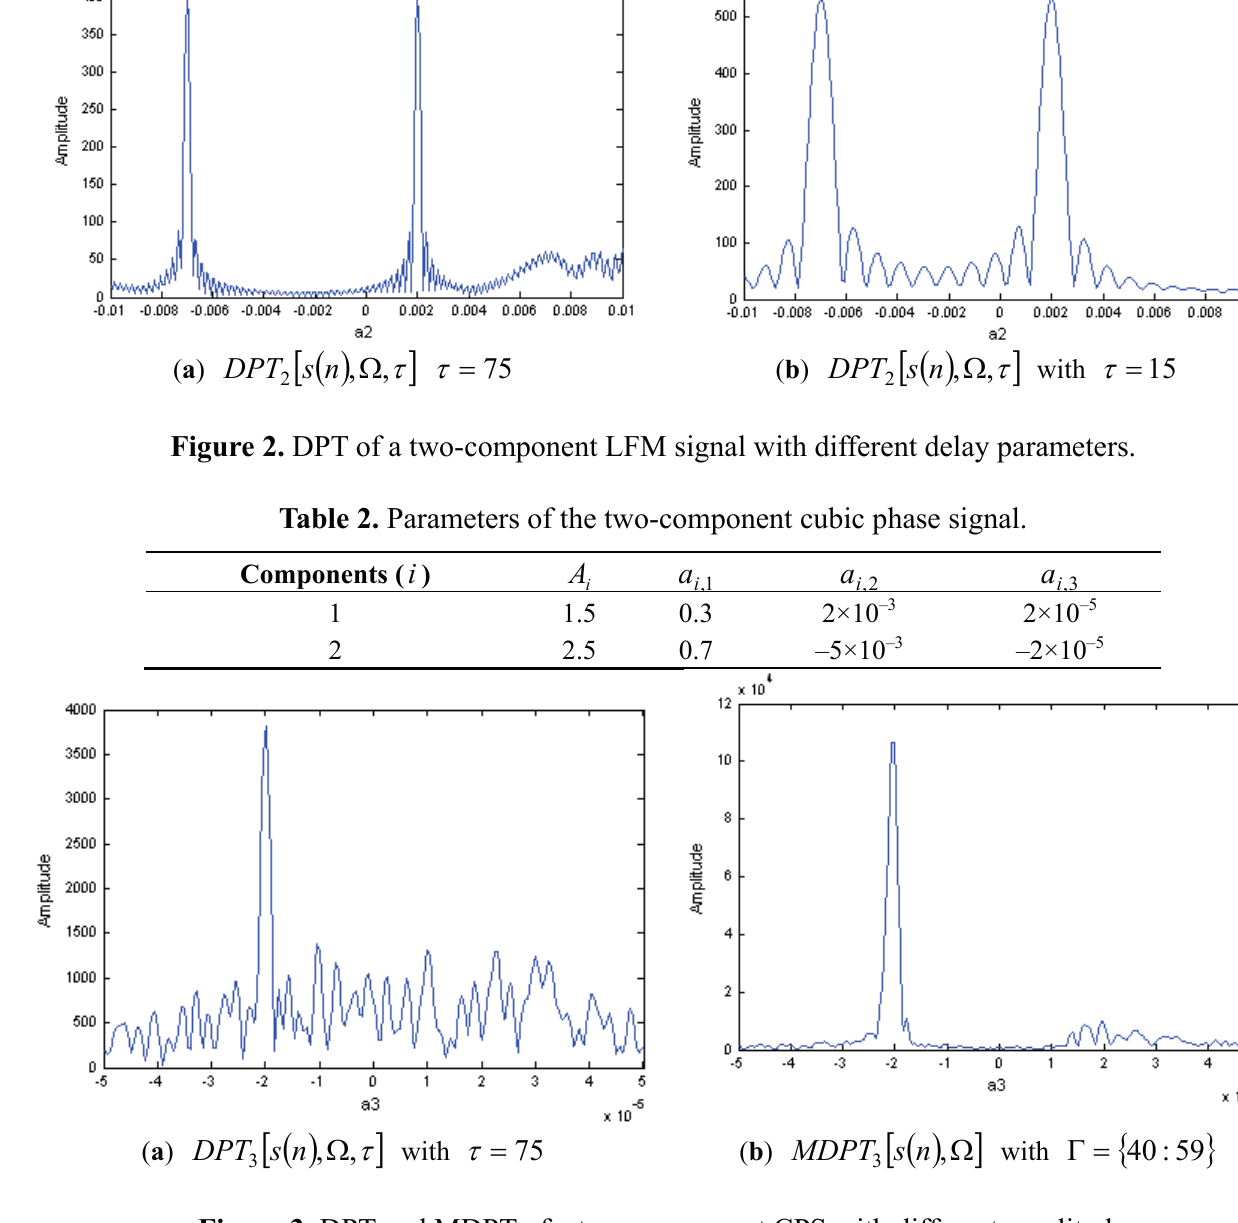
Figure 3. DPT and MDPT of a two-component CPS with different